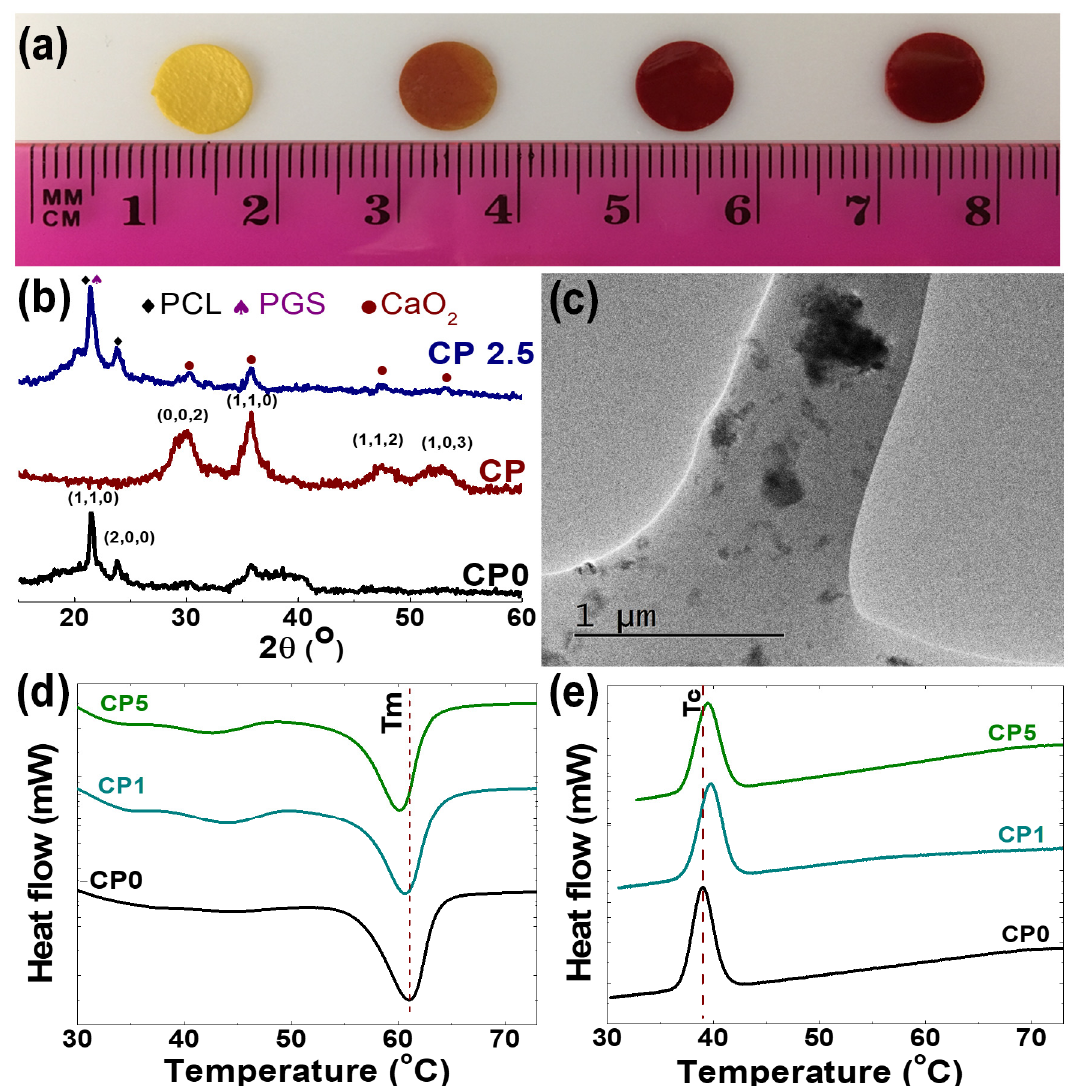
Figure 2. ( a ) Alizarin red S staining of the electrospun sheet with different concentration of CP, confirms incorporation of CP in PGS/PCL polymer network. ( b ) XRD spectra of CP nanoparticles, PCL/PGS scaffold and composite scaffold. ( c ) TEM image of the electrospun composite nanofiber demonstrates embedding of CP nanoparticles within the fiber. ( d , e ) DSC curve of PGS/PCL scaffold with different concentration of CP scaffold during heating ( d ) and cooling ( e ).